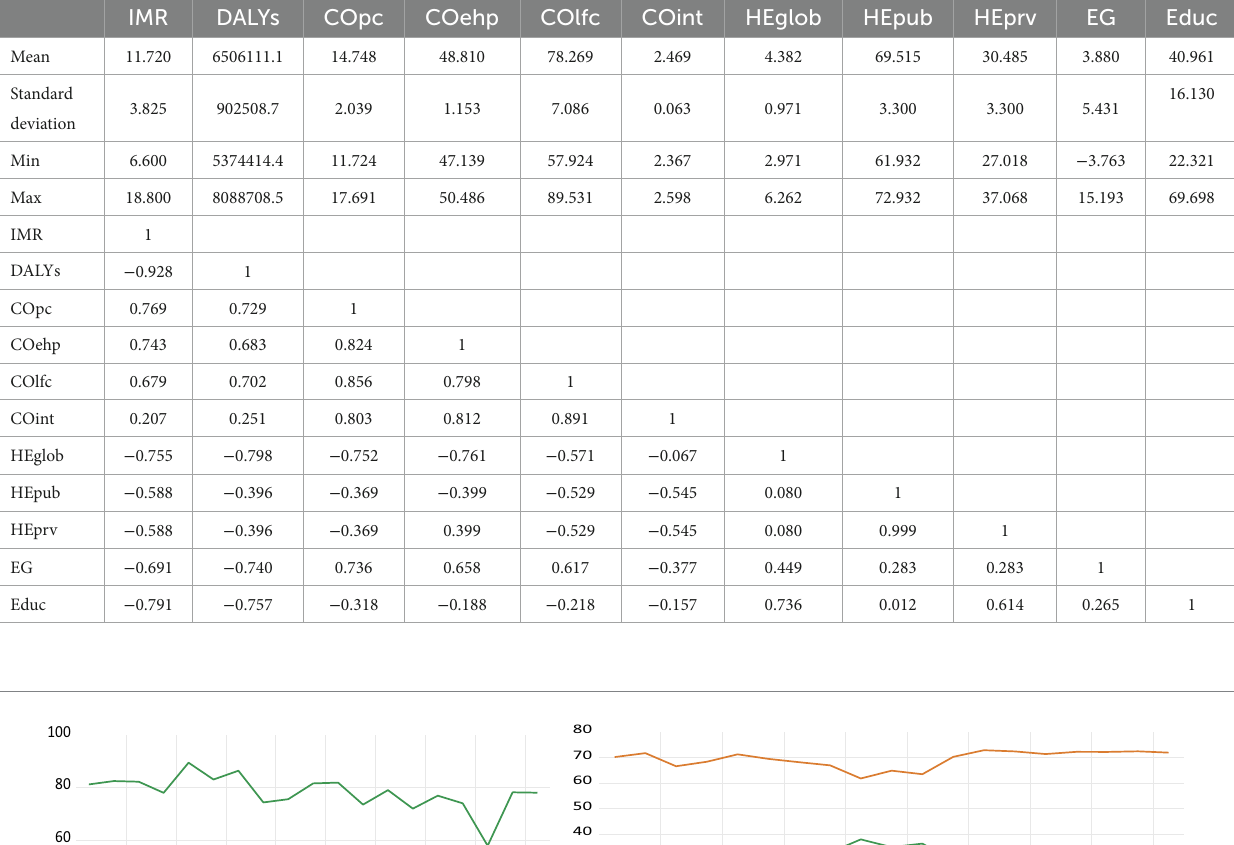
TABLE 1 Descriptive statistics and pairwise